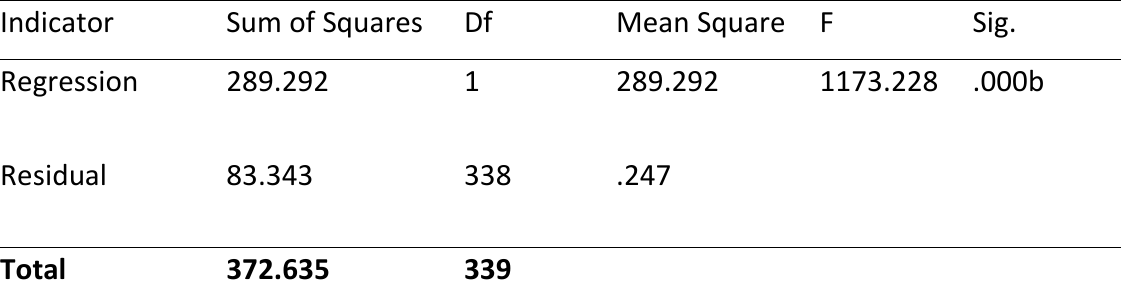
Table 11. Analysis of